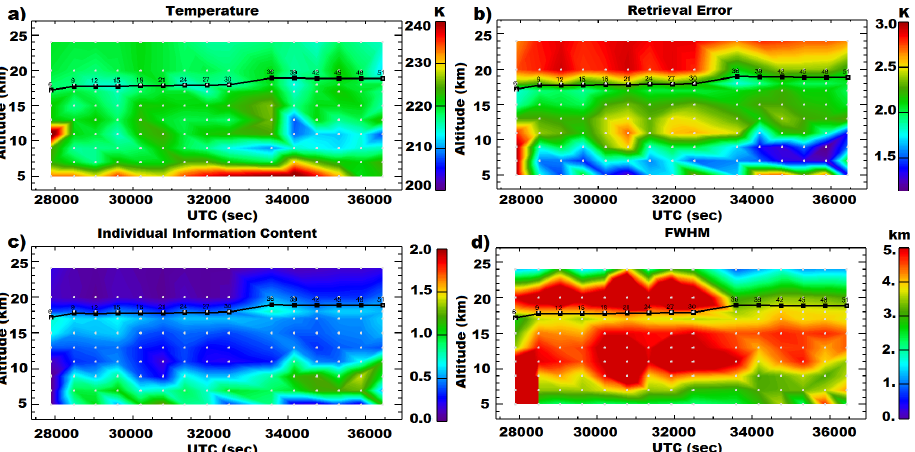
Fig. 5. Maps of retrieved values and quantifiers plotted as a function of altitude and acquisition time. The black line is the aircraft altitude and the black dots mark every single scan. White dots mark the used retrieval grid points. (a) Temperature retrieved from band C scans, (b) its retrieval (biased) error, (c) the individual information content and (d) the vertical resolution (FWHM).